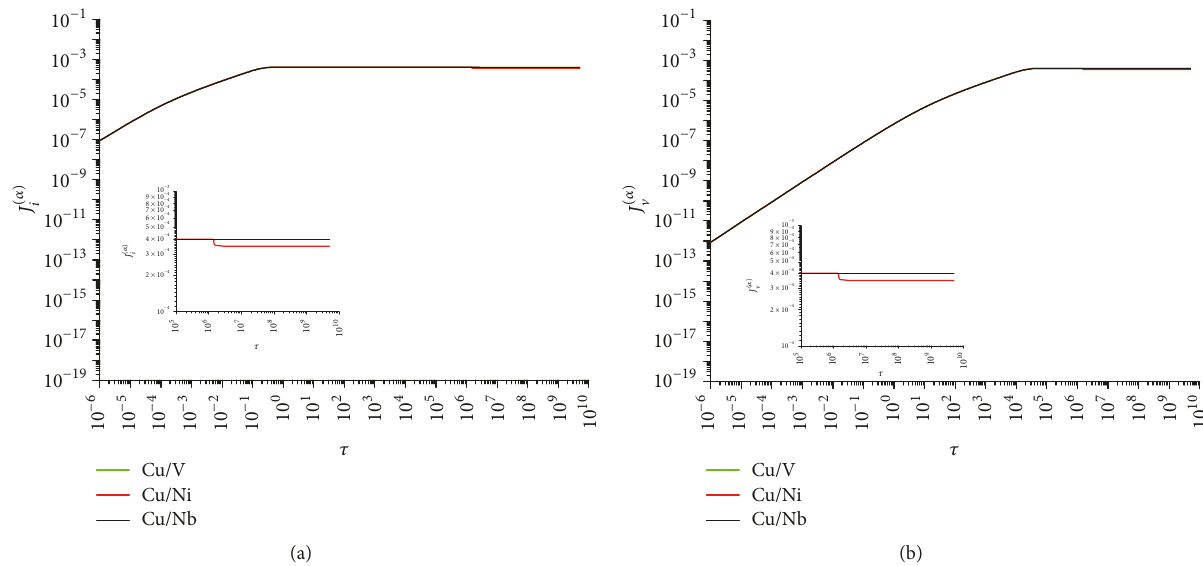
Figure 5: Temporal profiles of (a) SIA and (b) vacancy flux from layer 𝛼 to the interface between metals 𝛼 and 𝛽 .